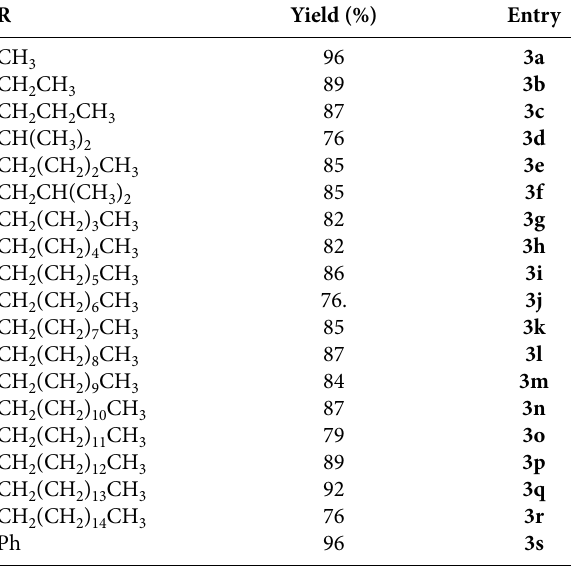
Table 1. Eugenyl esters: chemical entity, yields (%) and entry Yield (%)